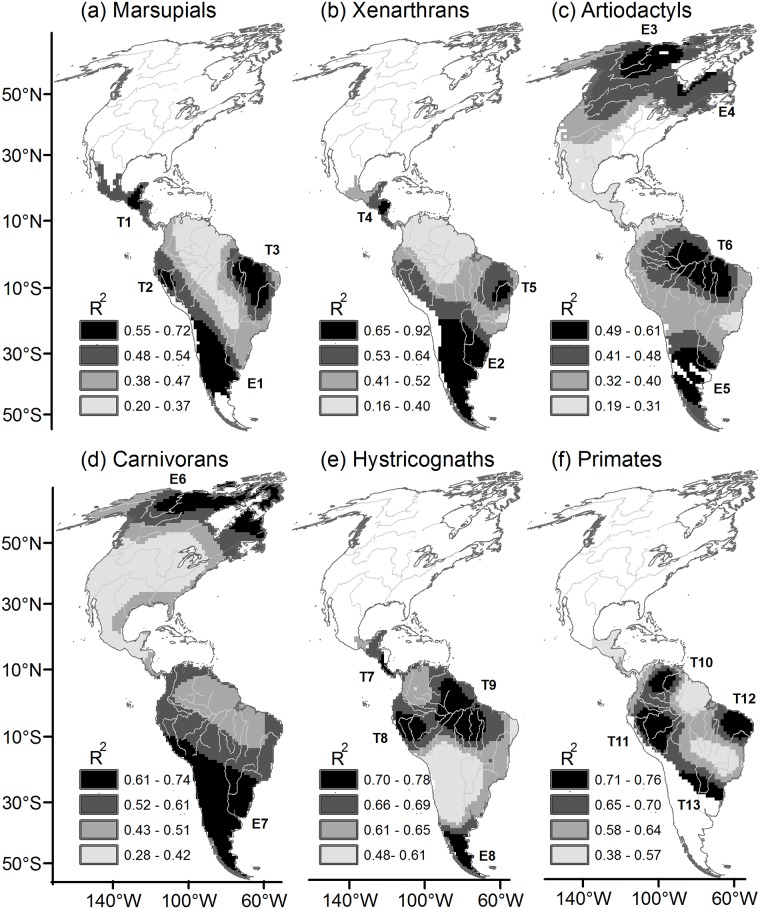
Local coefficients of determination (R2) obtained from geographically weighted regression (GWR), indicating the proportion of variation in taxonomic richness (TR) accounted for by the environmental predictors and phylogenetic diversity (AvPD).Local R2 values are displayed according to quartiles; high R2 areas corresponded to the upper quartiles shown as black areas. T = tropical, E = extra-tropical. Maps are in Mollweide equal-area projection.